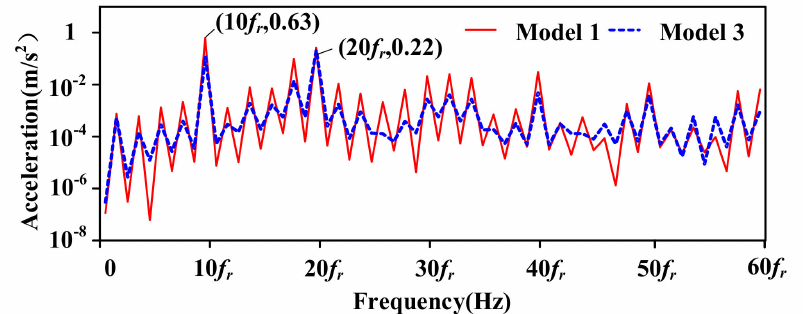
Figure 15. Radial vibration characteristics of Mode 1 and Model